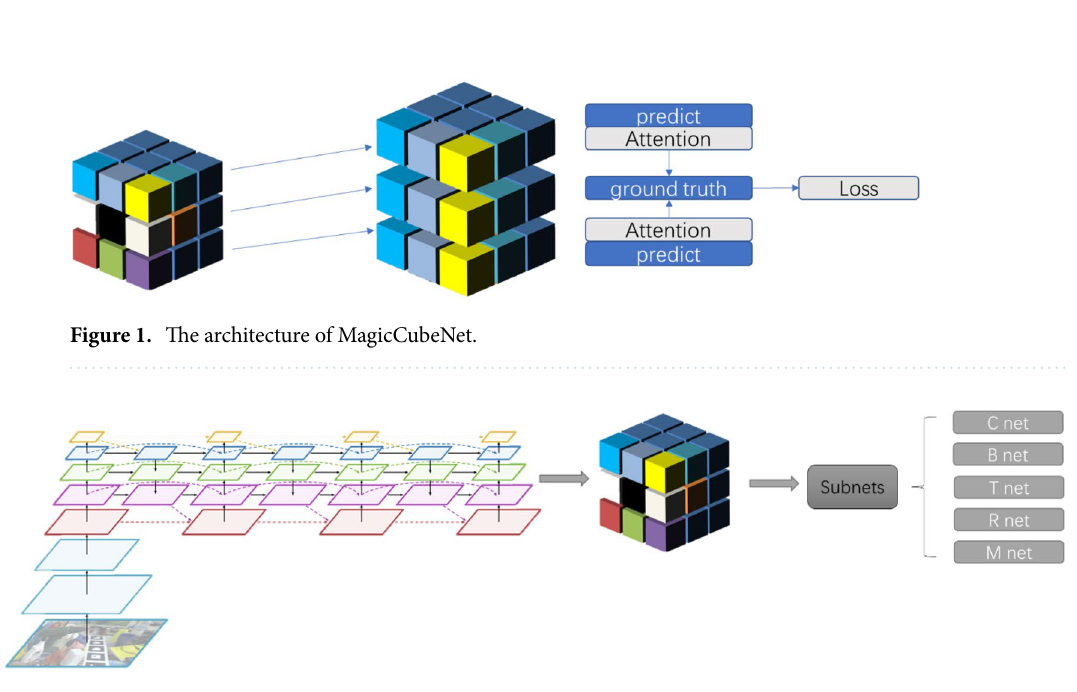
Figure 2. The architecture of MagicCubePose, which is based on EfficientDet, including the EfficientNet backbone, the bidirectional feature pyramid network (BiFPN) and